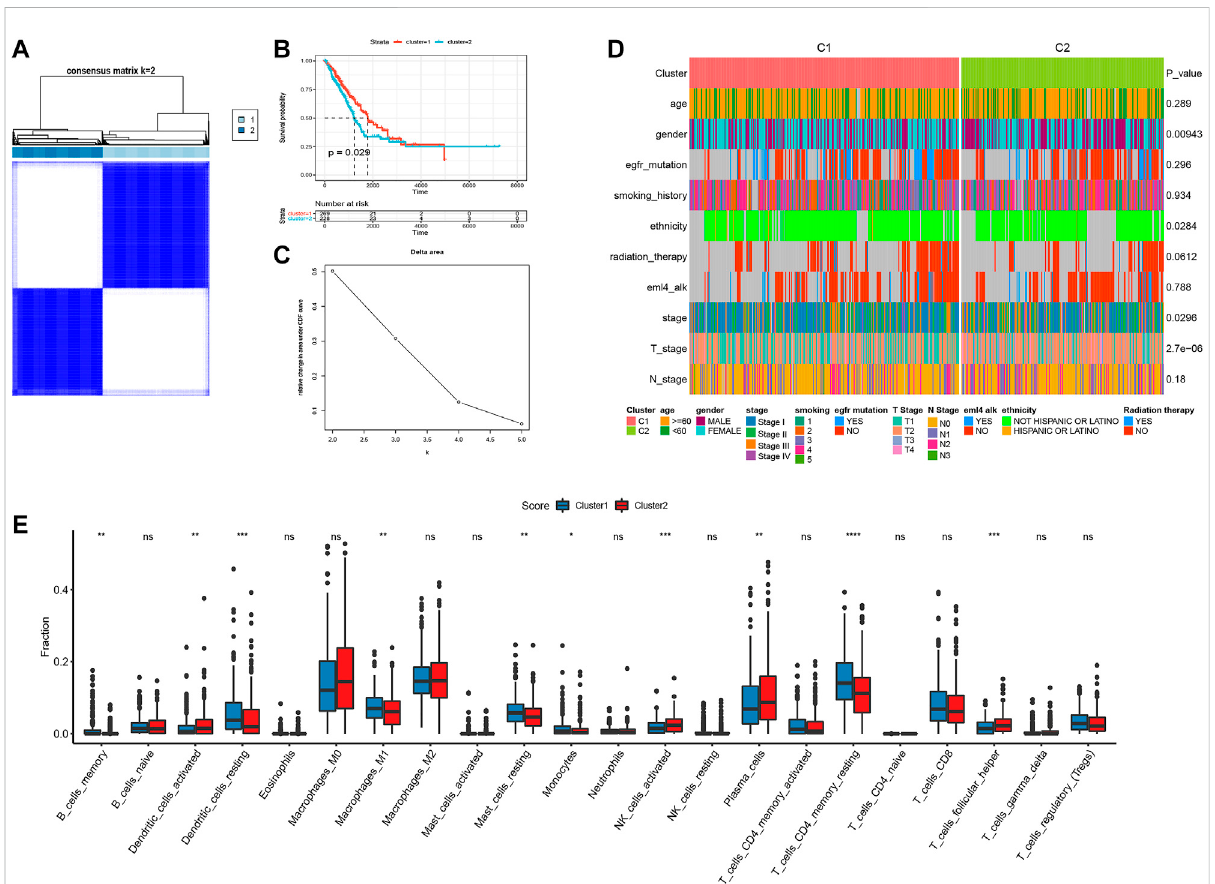
FIGURE 3 Consistentclusteringresultoftumorsamples (A) ;SurvivalcurvesandCDFcurvesofthetwosubtypeswereobtainedaccordingtotheclustering results (B,C) ; Heat map of TRP subtypes and clinical features (D) ; 22 immune cell in fi ltration differences between subtypes (E) . * p < 0.05, ** p < 0.01, *** p < 0.001, **** p <